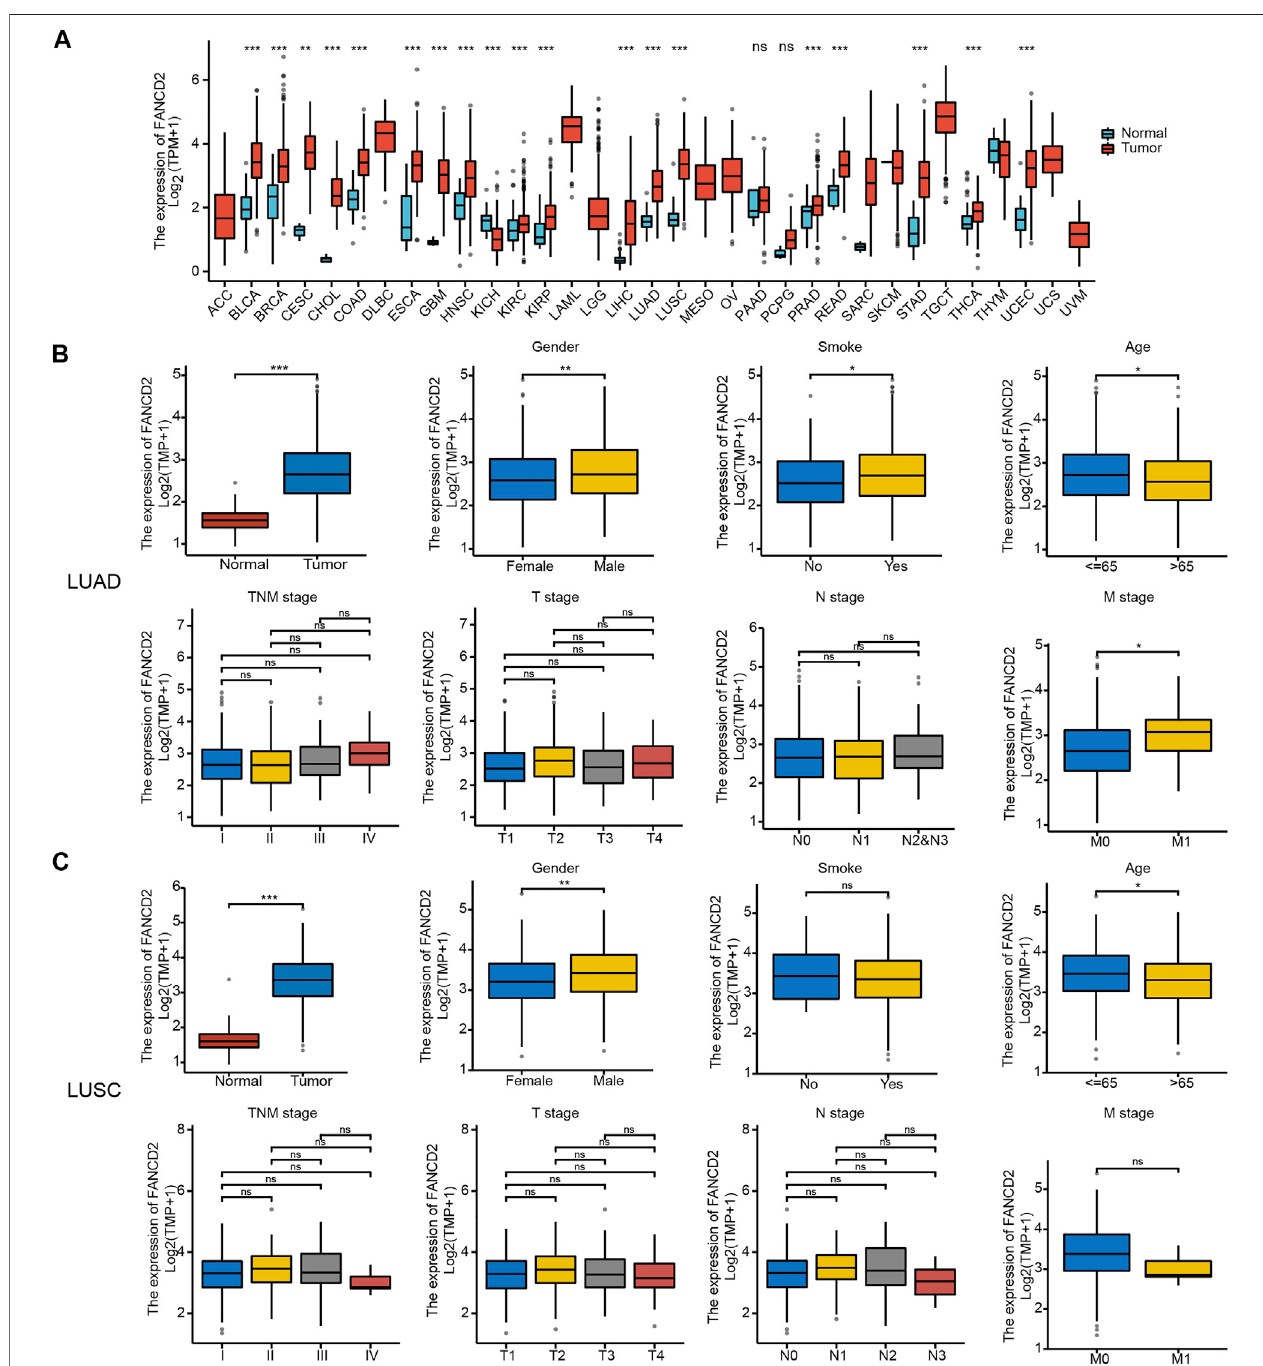
FIGURE 2 | Pan-cancer FANCD2 expression status and clinical characteristics in the LUAD and LUSC sub-groups. (A) FANCD2 expression status in different tumor tissues and adjacent normal tissues. (B,C) Comparison of FANCD2 expression levels with different clinical characteristics. * p < 0.05; ** p < 0.01; *** p < 0.001.